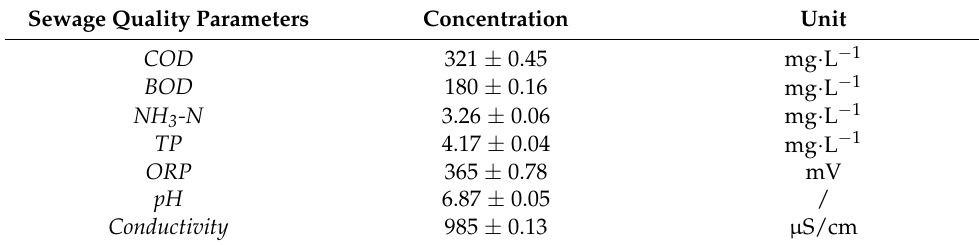
Table 2. Characteristics of